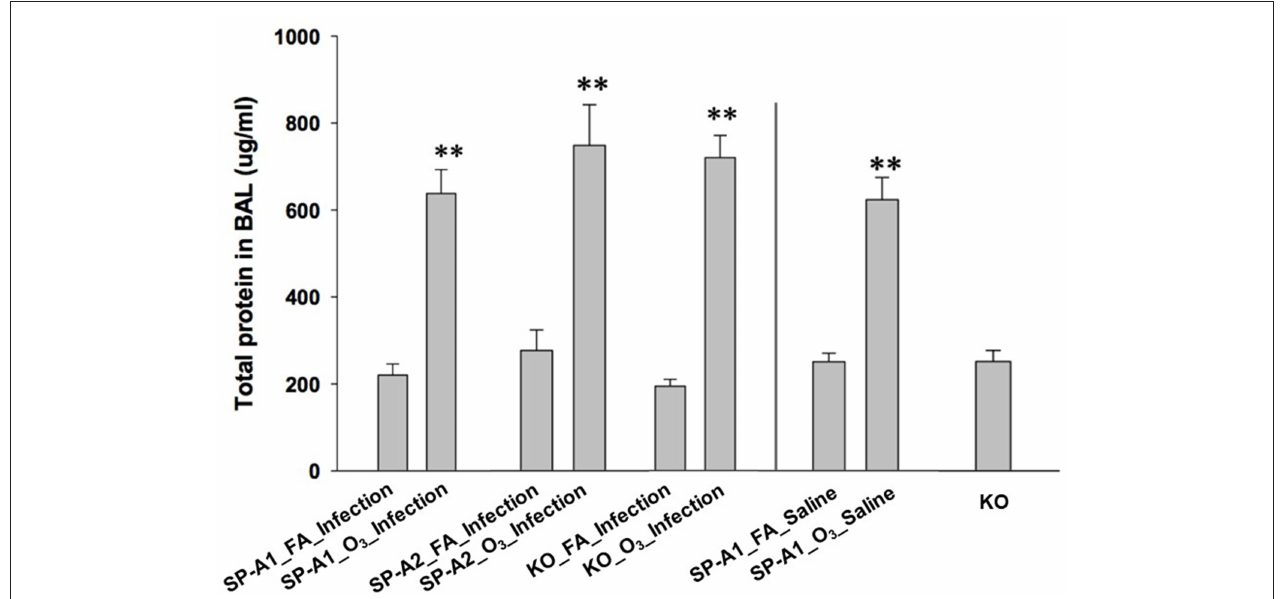
FIGURE 1 | Comparison of total protein concentration in the BAL fluid from exposed and infected mice. Three genotypes of mice (hTG SP-A1 and SP-A2 mice and SP-A KO mice) were exposed to ozone (3 ppm) or filtered air for 3h and then intratracheally infected with 50 µ l of bacterial solution (containing about 450 CFU of K. pneumoniae , control with 50 µ l of saline). After 24h of infection the mice were sacrificed and the lungs were subjected to BAL. Total protein concentration was determined in the supernatant of BAL. The results indicate that the total protein level of ozone-exposed mice, regardless of bacterial infection or saline control was significantly higher than that of FA-exposed mice (** p < 0.01). No significant difference is found among FA-exposed mouse groups regardless of infection or saline control, or among ozone-exposed mouse groups regardless of infection or saline control. In addition, no significant differences in total protein level in the BAL fluid are observed between KO background control and FA-exposed mice regardless of infection or saline control (The experimental groups and controls were separated by a vertical line).